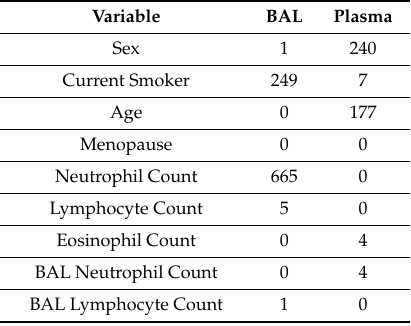
Table2. Significantlyassociatedcompoundswithclinical, cell-type,